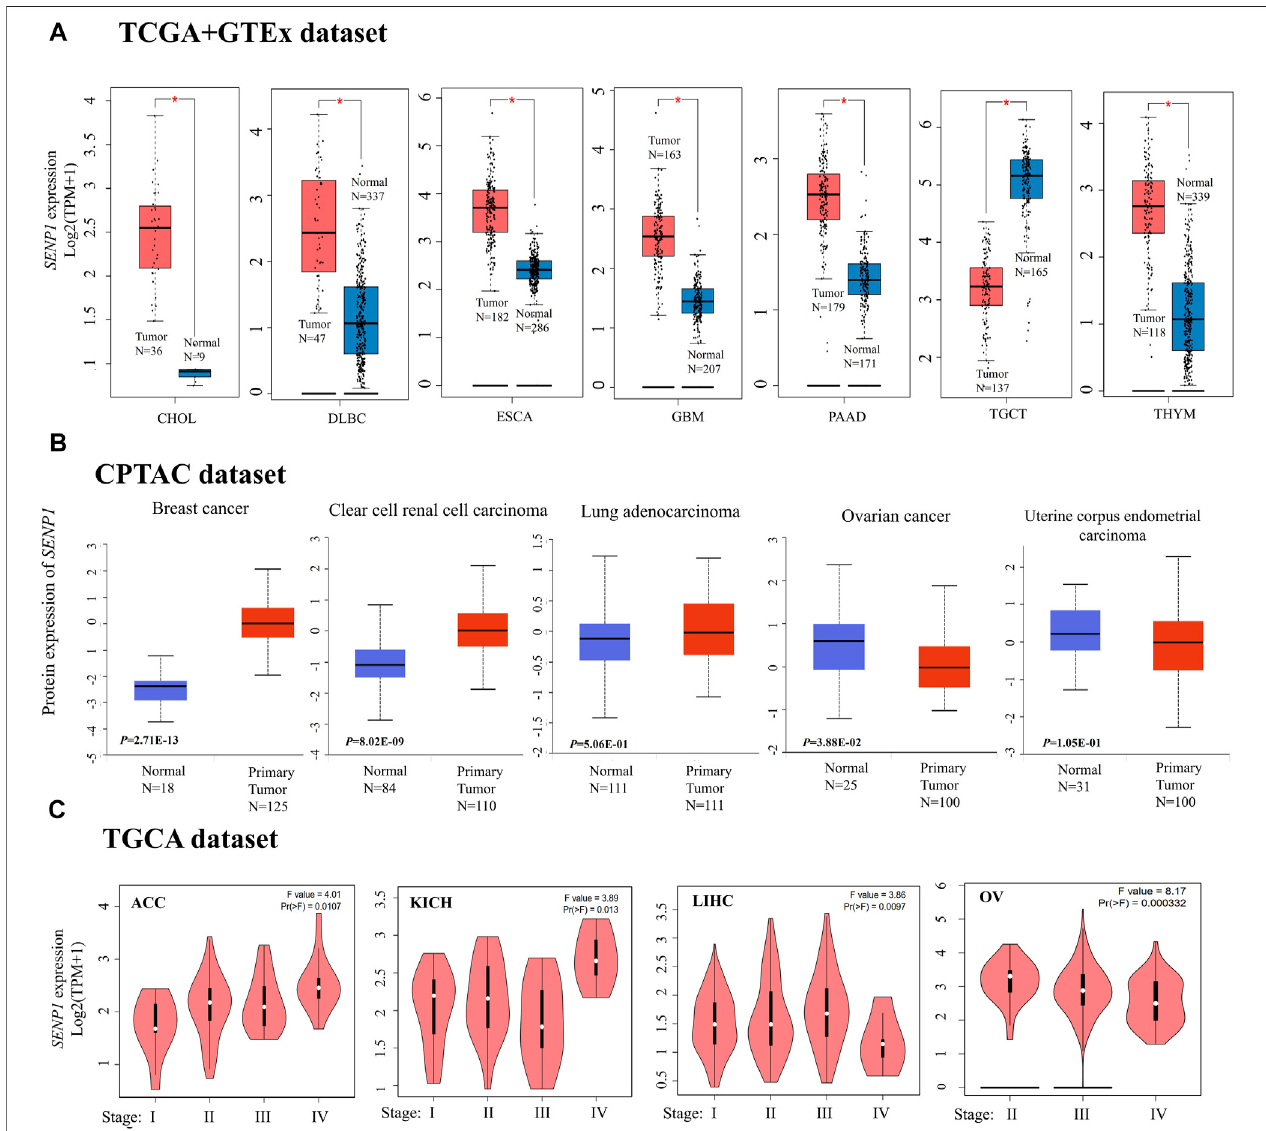
FIGURE 2 | SENP1 expression, (A) Box plots of SENP1 expression in tumor tissues compared with normal tissues, (B) SENP1 total protein in tumor tissues compared with normal tissues, and (C) SENP1 expression in the different stages of cancers ACC, KICH, LIHC, and OV.